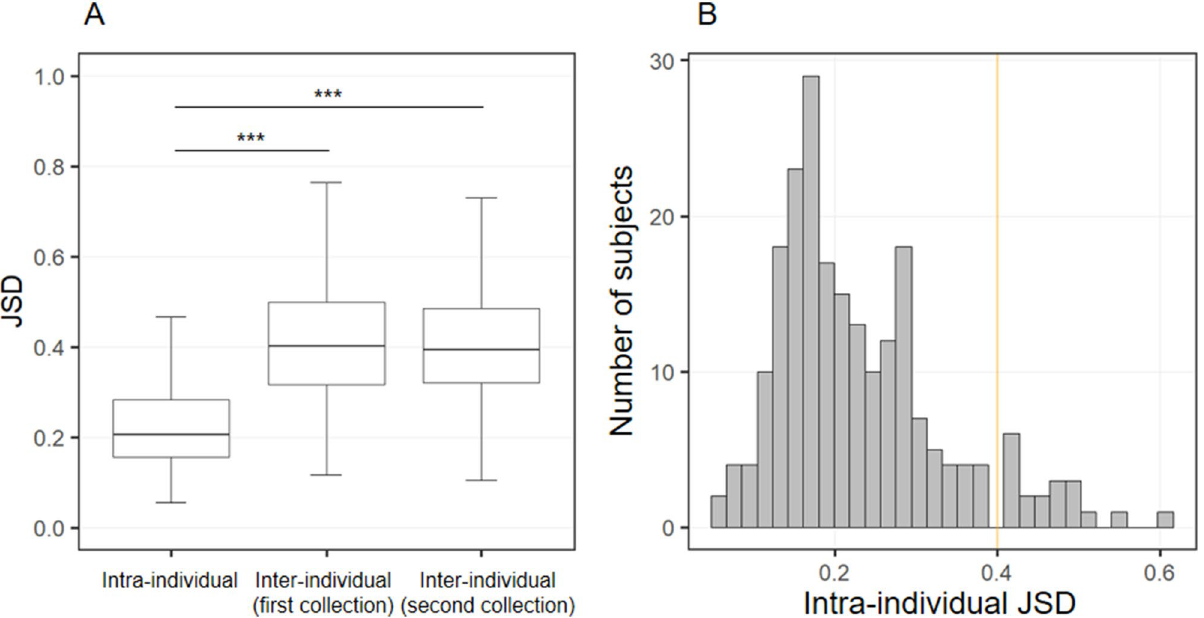
Figure 1. Intra-individual variations and inter-individual differences in gut microbial composition, quantified by Jensen-Shannon distance (JSD). ( A ) Comparison of JSD values between intra-individuals and inter- individuals by Steel’s tests. *** P < 0.001. ( B ) Distribution of intra-individual variations among the 218 subjects. The orange line indicates the median of the inter-individual JSDs (approximately